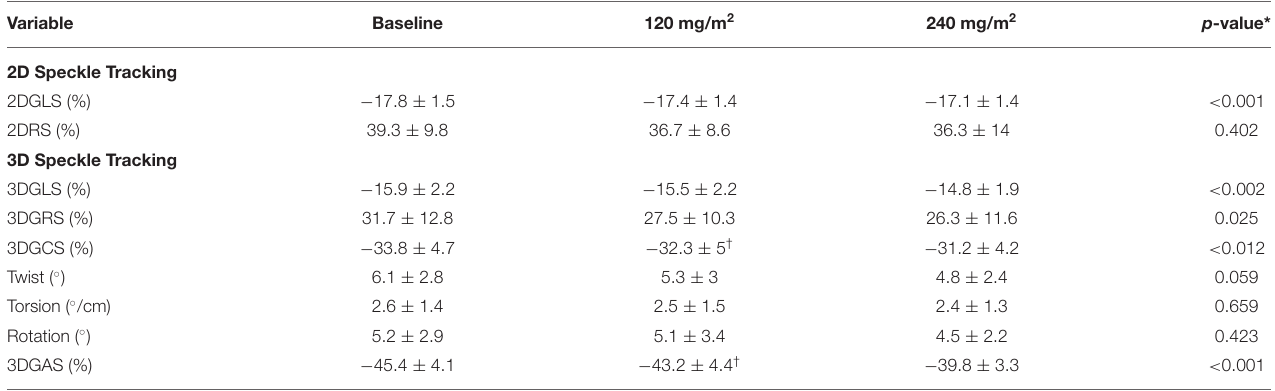
TABLE 5 | Results of myocardial deformation parameters derived from 2DSTE and 3DSTE during the treatment. Variable Baseline